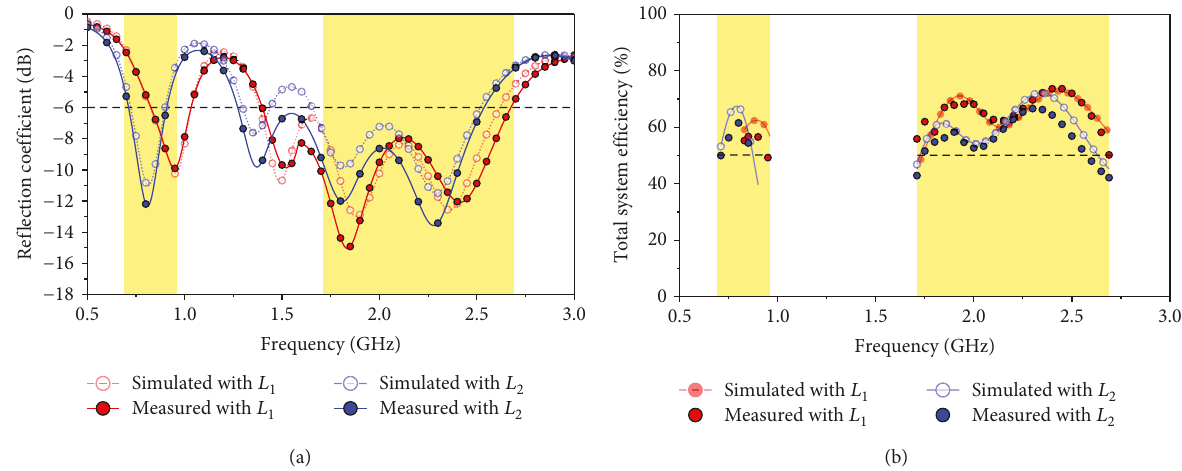
Figure 8: Measured and simulated (a) reflection coefficient and (b) total system efficiency of the fabricated crossed-loop LTE antenna inside a metal-rimmed smartphone prototype featuring 2mm ground